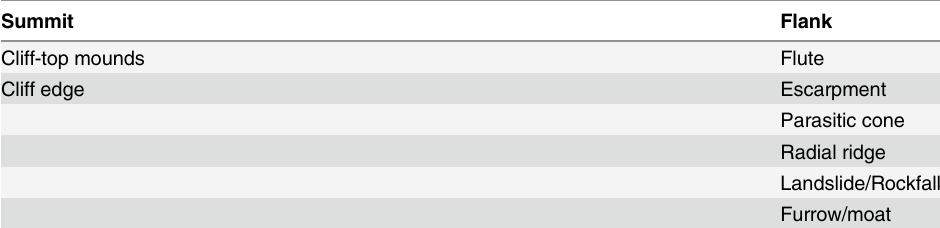
Table 1. Meso-scale geomorphological features identified from the summit and flank of Anton Dohrn Seamount. Summit